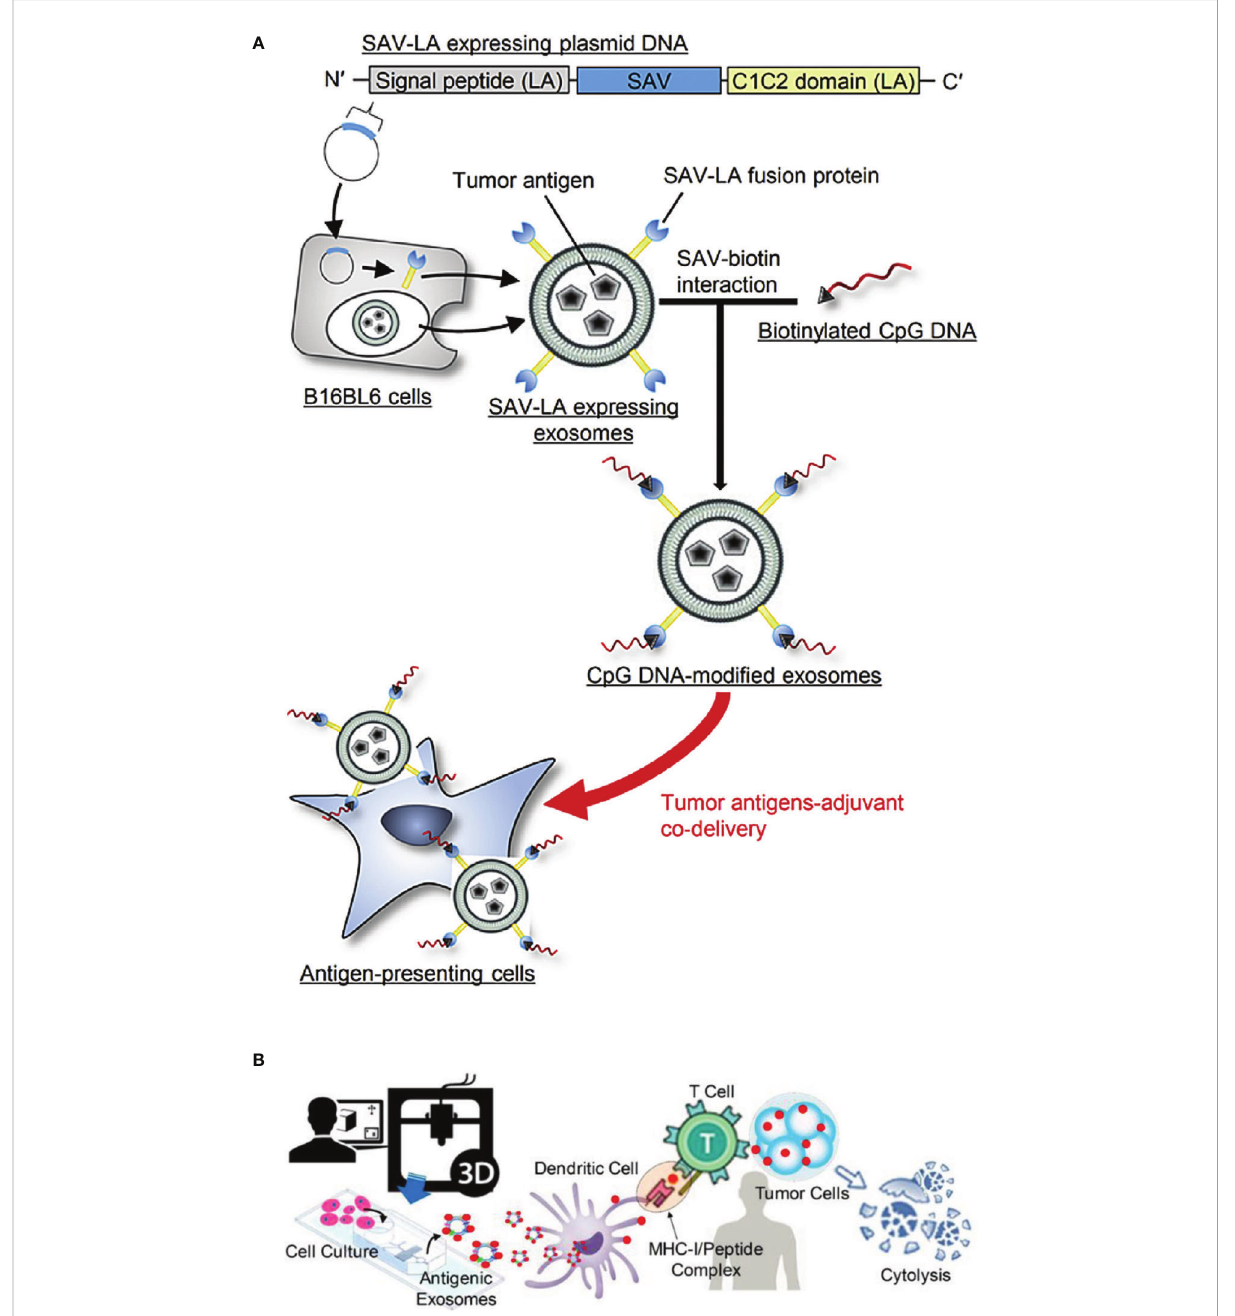
FIGURE 7 (A) The scheme of CpG-SAV-exo to deliver APCs (Reprinted with the permission from Ref. 9); (B) The scheme of MHC-I positive exosomes for activating anti-tumor responses (Reprinted with the permission from Ref. 171). SAV; Streptavidin, SAV-LA; N-terminal secretion signal of lactadherin (LA) and C1C2 domain of